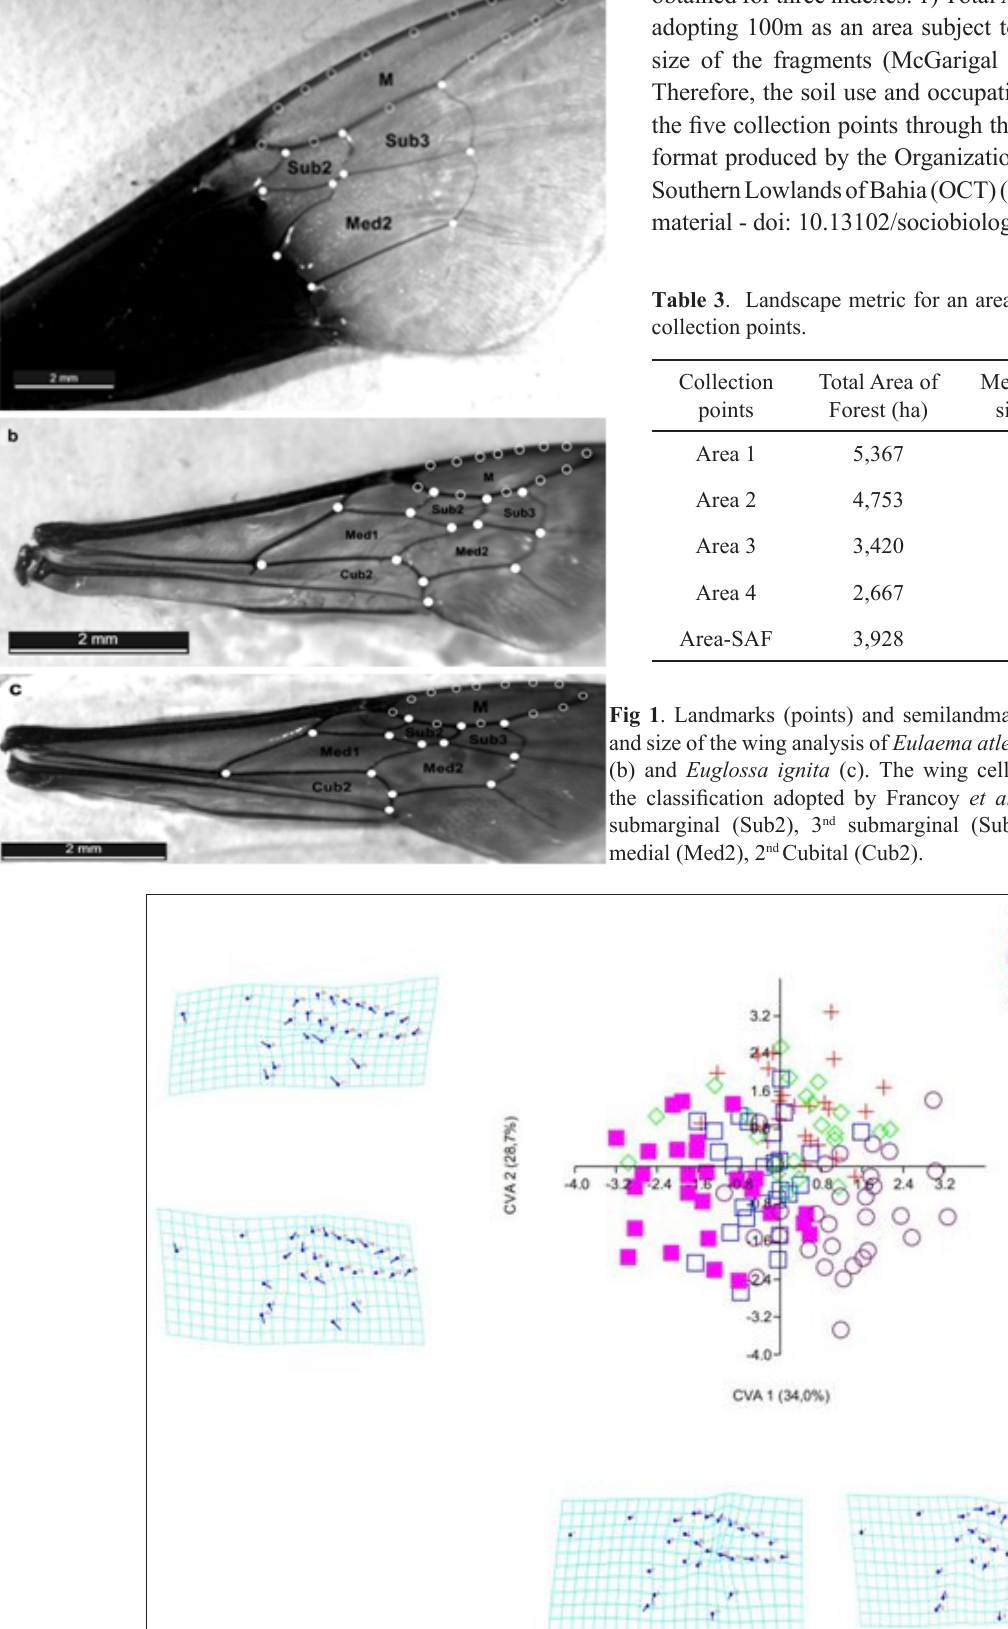
Fig 2 . Scatter plot of the five populations of Euglossa ignita in relation to the canonical variables CVA 1 and CVA 2, arranged in a Cartesian plane and obtained from the wing shape. The deformation diagrams for the negative and positive sides of each axis are around the